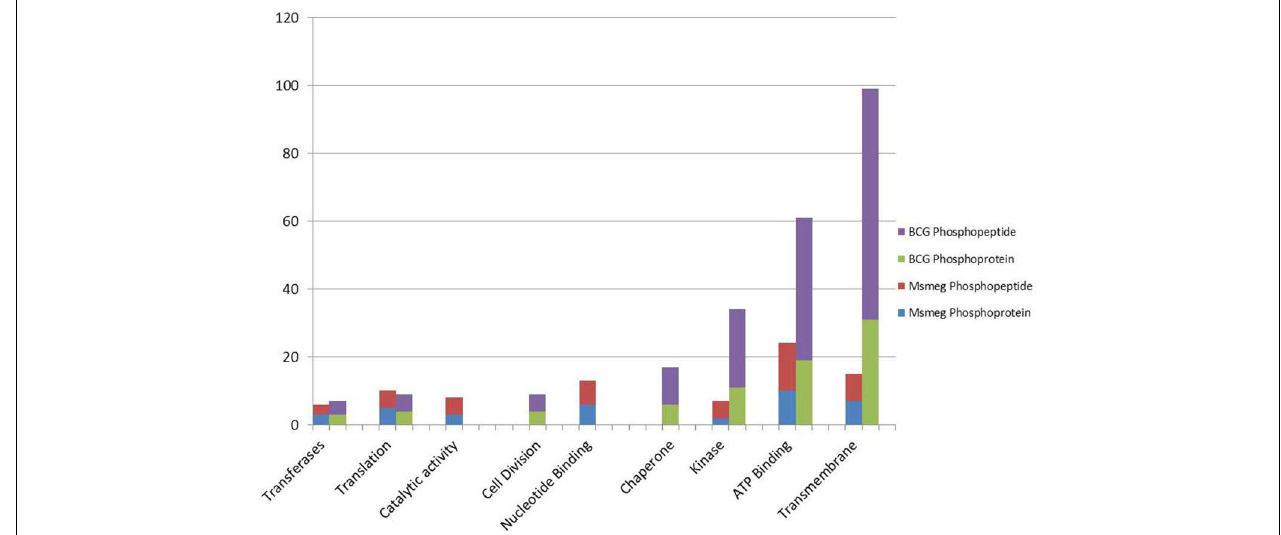
FIGURE 2 | A histogram showing the GO molecular functions of identified phosphoproteins and respective number of phosphopeptides as predicted from their genome annotations.